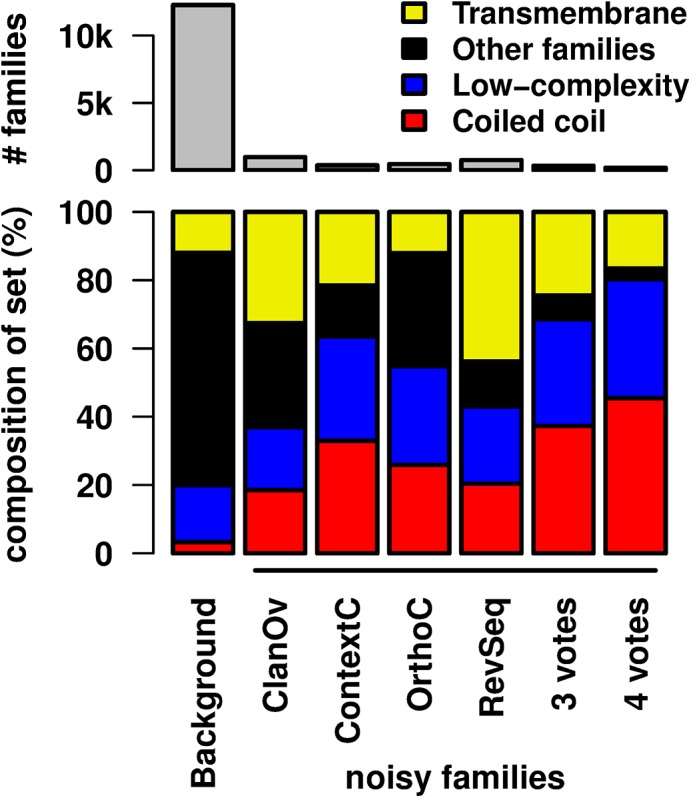
Families with increased noise are enriched for repetitive patterns.Each Pfam family is classified as transmembrane domain, low-complexity region, coiled-coil, or “other” (Methods). The “background” bars correspond to all Pfam families, and the other bars correspond to noisy families, or those with significantly larger empirical FDRs than expected with q ≤ 1e-2 using either ClanOv, ContextC, OrthoC, RevSeq, at least three of these tests (3 votes), or all four tests (4 votes). The top (gray) bars show the set size, and the bottom bars (colors) show the set composition. Category enrichments are evaluated using the hypergeometric distribution, and two-sided p-values with p ≤ 0.01 are declared significant. All noisy sets are significantly enriched for coiled coils and de-enriched for “other” families. Low-complexity regions are significantly enriched in all sets except ClanOv. Transmembrane domains are significantly enriched in all sets except OrthoC and “4 votes.”